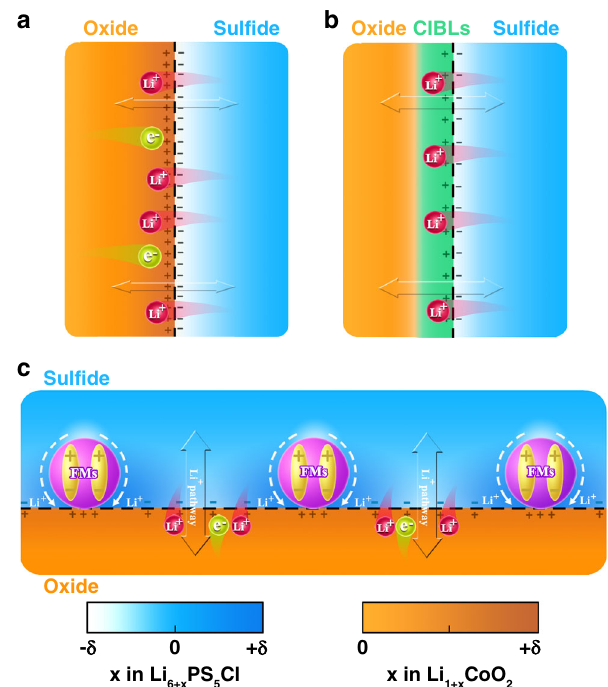
Fig. 5 Schematic illustration of interface charge redistribution between oxide cathodes and sul fi de SEs after different interface engineering approaches. a Initial interface. b Double-phase interface with fast Li-ion conductor CIBLs. c TPI with discontinuous ferroelectric nanoparticles. The regions with light colors correspond to the relative Li-ion de fi ciency. FMs ferroelectric materials.